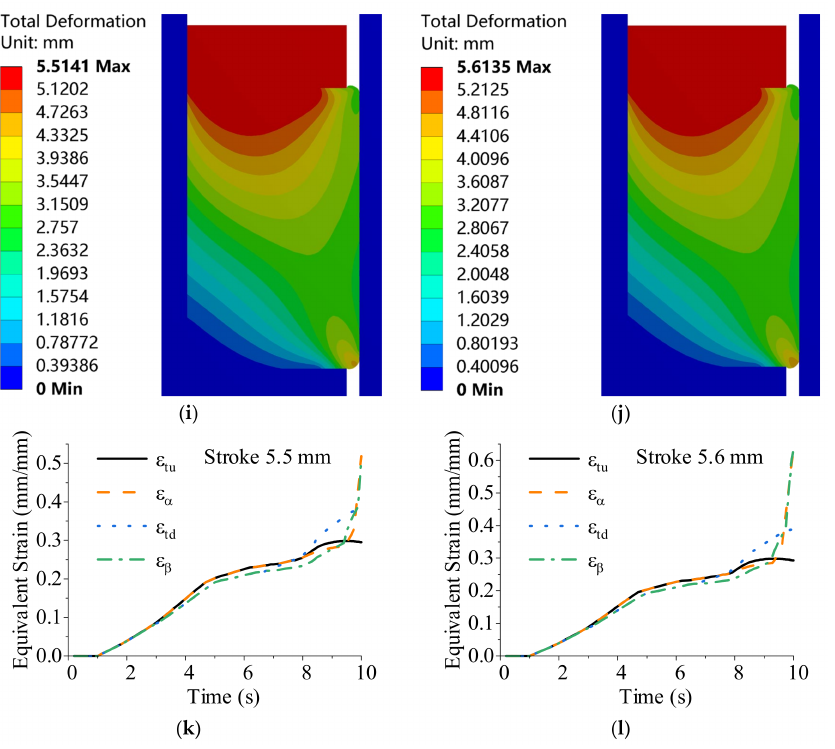
Figure 6. Diagram of comparison of compression distance and maximum equivalent strain. ( a ) 5.1 mm compression distance; ( b ) 5.2 mm compression distance; ( c ) Equivalent strain